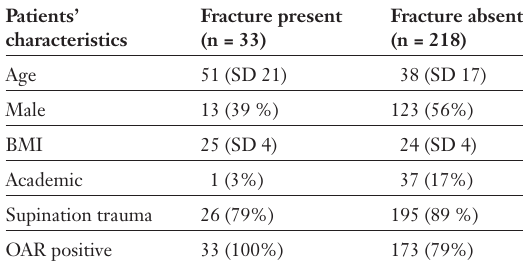
Showing population means (SD) or num- bers (percentage) were